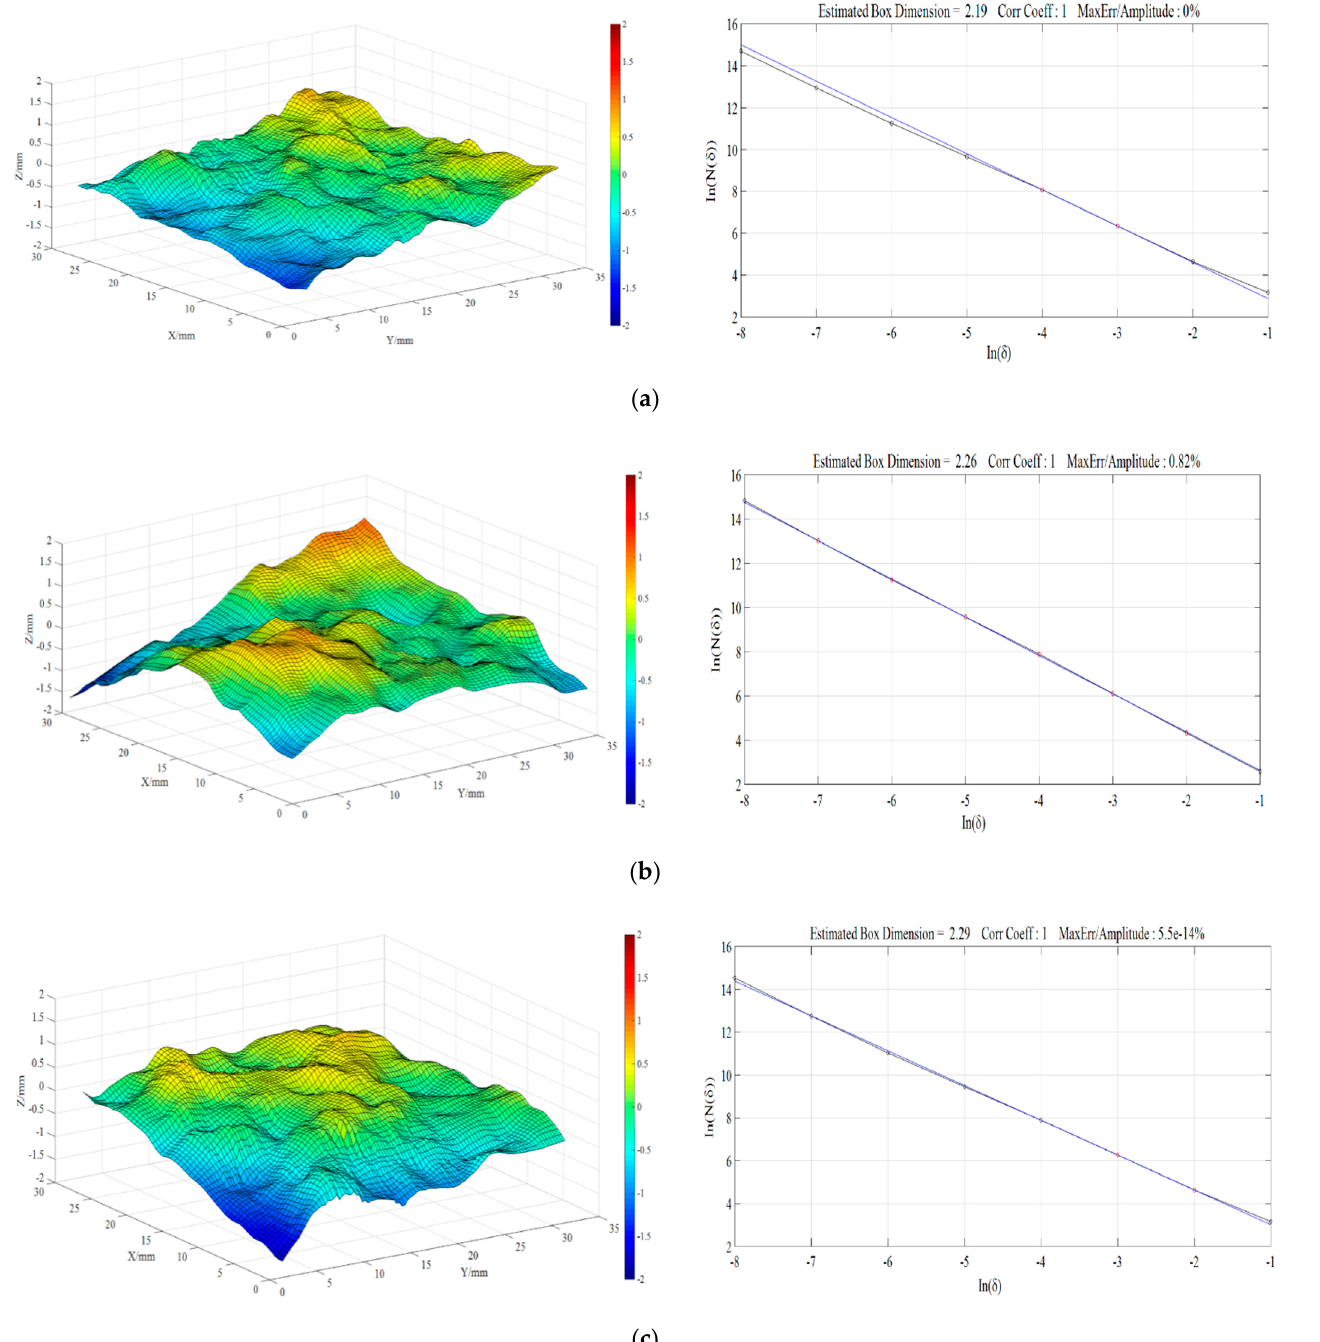
Figure 12. Digitized fracture surfaces and the associated fitting results of ln N( δ ) and ln δ . ( a ) ANSCB − I, ( b ) ANSCB − II, and ( c ) ANSCB − III.